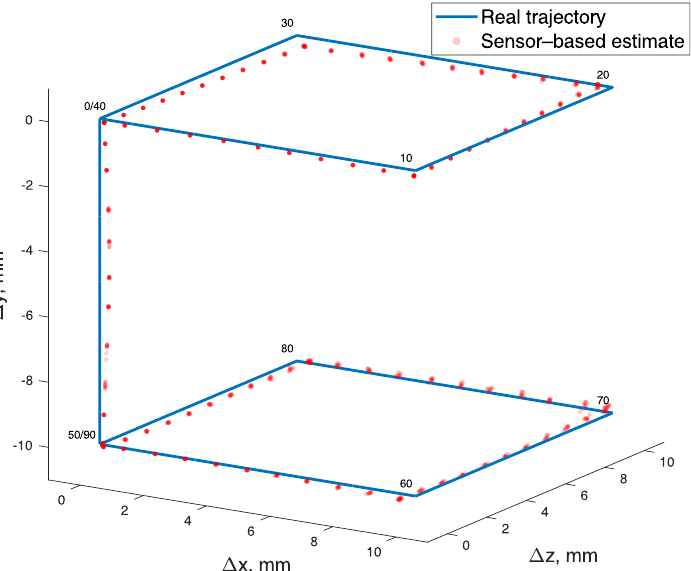
Figure 9. Cubic test trajectory drawn with a 3D positioning system (blue) and determined from mag- netic field values (red). Measured points are numbered 0 to 90, and all 10 iterations are represented in transparent